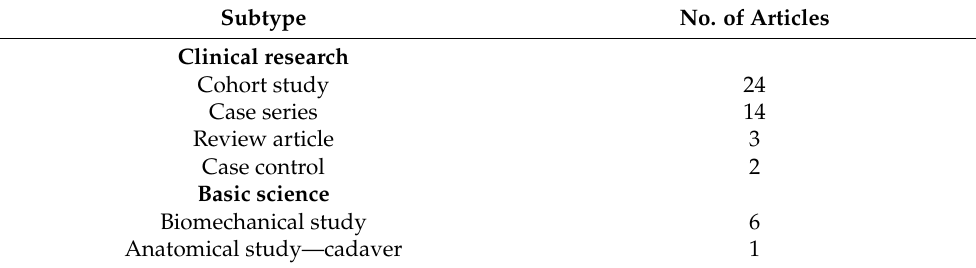
Table 2. Subtypes of the 50 most-cited papers on shoulder arthroplasty.